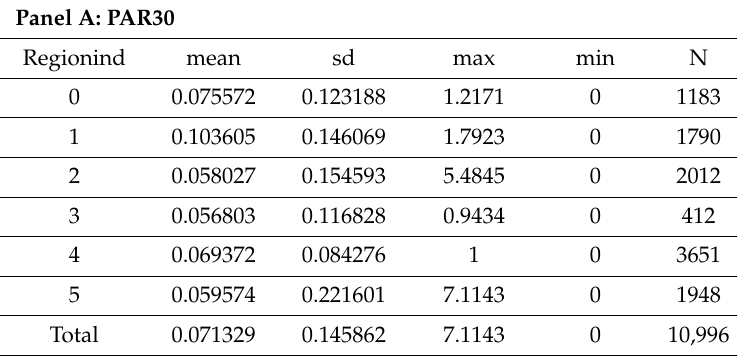
Table 4. Summary statistics for MFIs in different